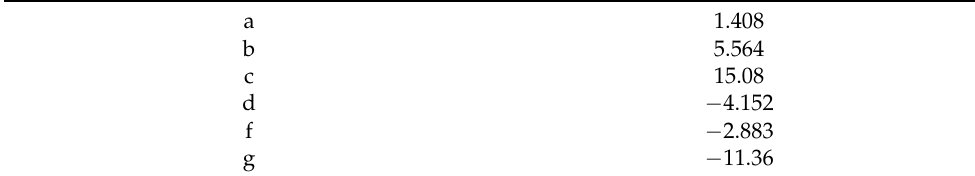
Figure 8. Fitting results of reaction times. ( a ) Sota, ( b ) Nao, ( c ) Pepper, ( d ) Male, ( e ) Female. Table 6. Coefficients for the fitting fuction of